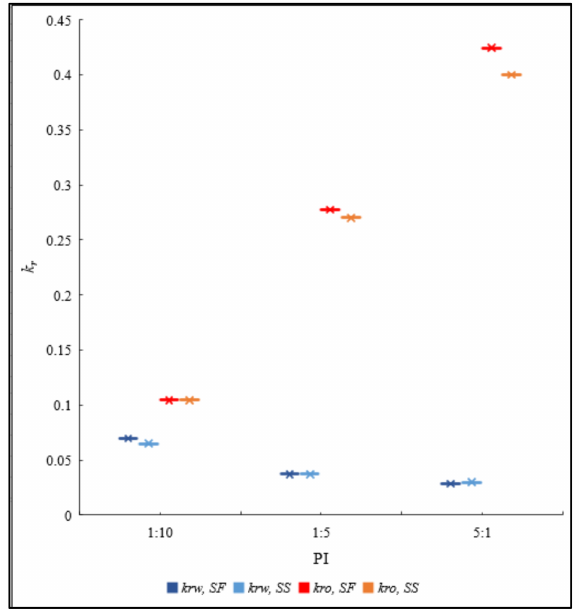
Figure 6. Comparison of the correction results of the wetting phase and the non-wetting phase of the stability factor method (SF) and the method proposed by Moghaddam (SS) when the PI = 0.1, PI = 0.2, and PI = 5.